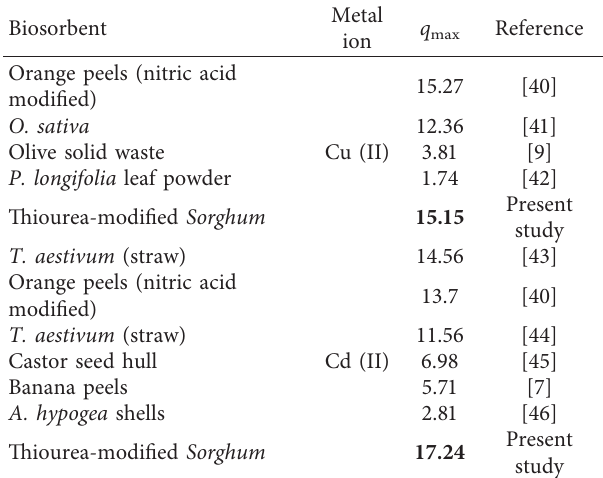
Table 4: Comparison of maximum removal capacities with re- ported